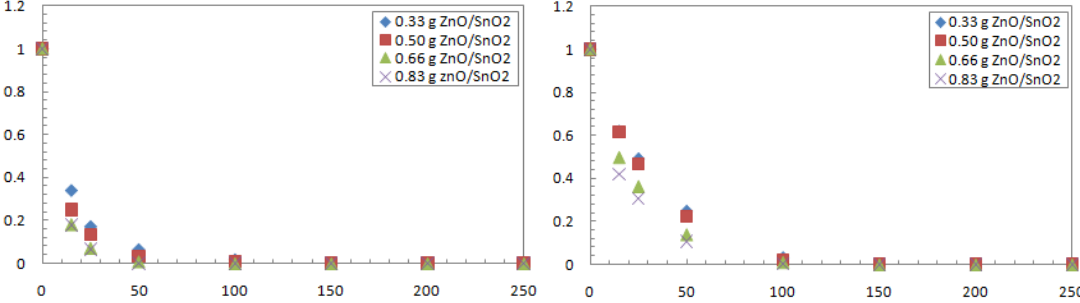
Fig. 12.The effect of 0.33, 0.50, 0.66 and 0.83 g amounts of ZnO/SnO 2 nanocomposite in the presence of 20 mg/Lmethylene blue.